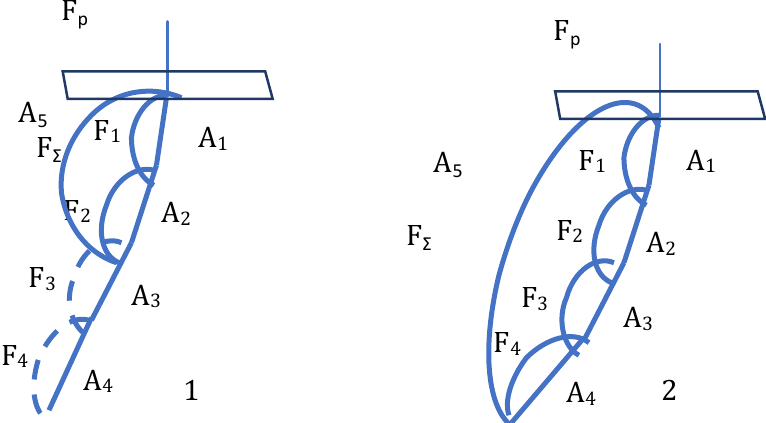
Fig. 3. Diagram of the kinematic chain in various models of hanging in rock climbing (bouldering): 1 - model 1 (wrong technique); 2 - model 2 (correct technique); Fp - the force of fastening on the support, equal to the reaction force of the support; FΣ is the force holding the body on the support in the hanging; F1, F2, F3, F4 - forces arising from the tension of individual muscles; A1, A2, A3, A4, A5 - links of the kinematic chain (A5 - a link resulting from the tension of intertransmitting muscles); Model 1 - the kinematic chain is formed by a small number of links; the force holding the body in the hanging (FΣ) is due to the forces F1 and F2: FΣ = F1 + F2: Model 2 - the kinematic chain is formed by a large number of links; the force holding the body in the hang (F5) is due to the strength of the linksА